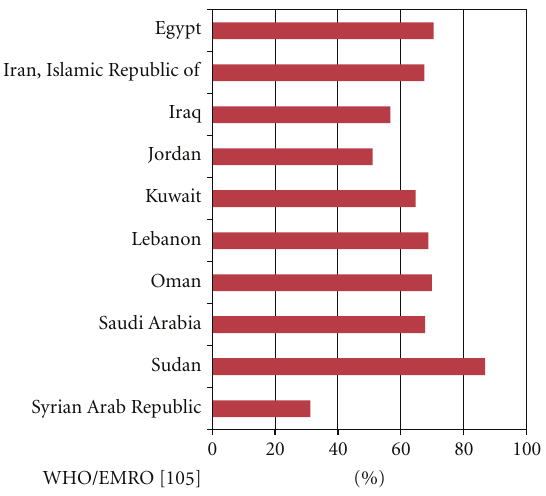
Figure 2: Prevalence of physical inactivity among adults in selected countries of the Eastern Mediterranean